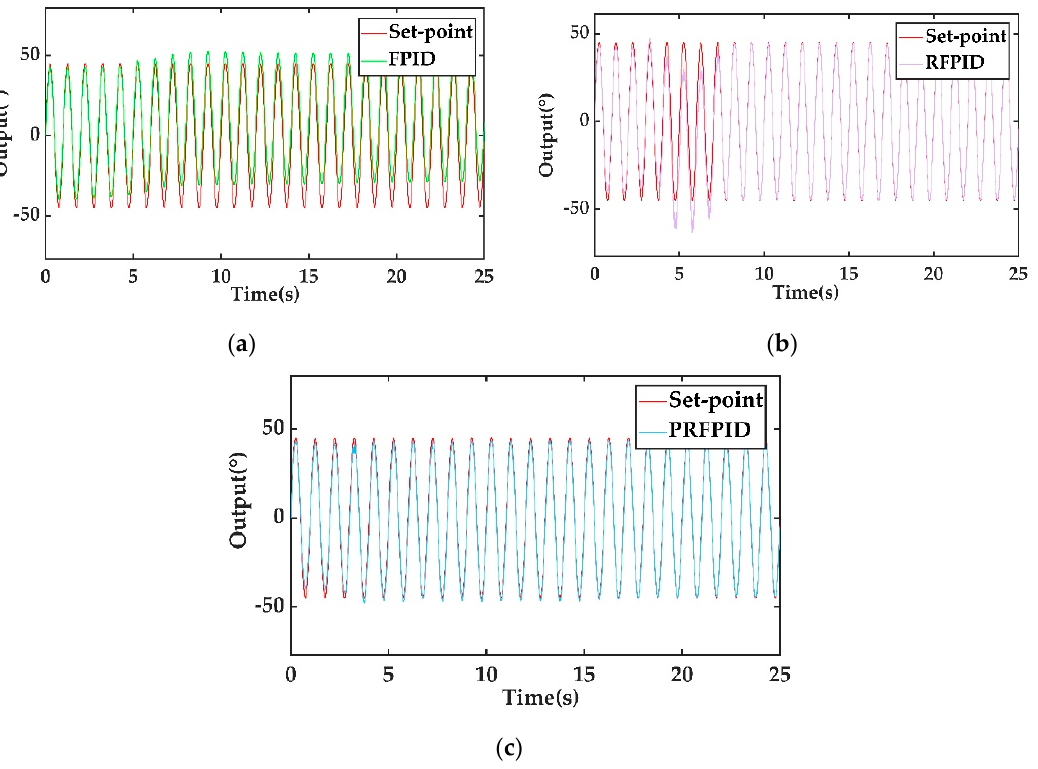
Figure 12. ( a ) FPID sine response; ( b ) RFPID sine response; and ( c ) PRFPID sine response.